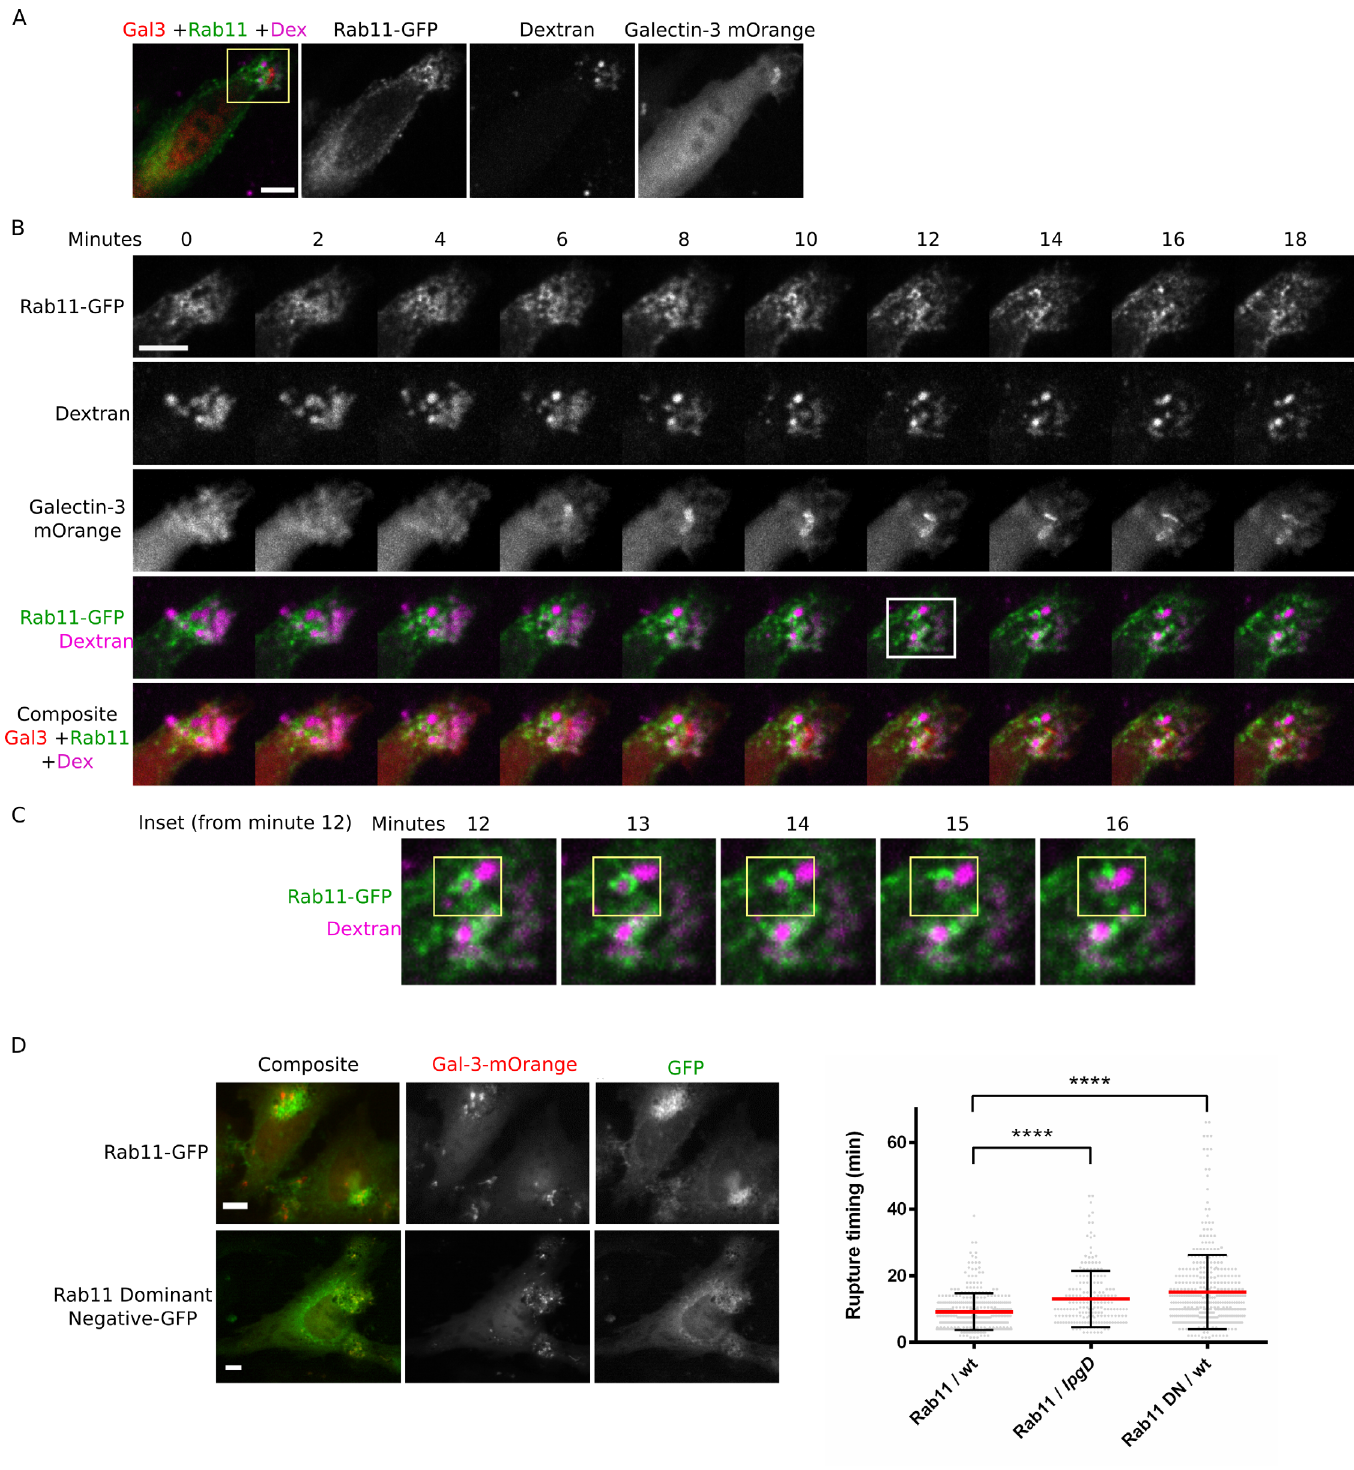
Fig 4. Rab11 is directly and dynamically recruited to macropinosomes and its activity is required for efficient vacuolar rupture. (A) Dextran pulse chase live imaging experiment. Overview of invasion site. (B) Time series of S . flexneri invasion. Inset from A is presented. Minute 0 represents the time when dextran was washed out and imaging was initiated. The onset of vacuolar rupture is observed in frame “ 6 ” . (C) Inset from B showing Rab11 is dynamically and directly recruited to a dextran labeled macropinosome (highlighted in yellow). Max projection of three slices is presented. See also S5 Movie. (D)